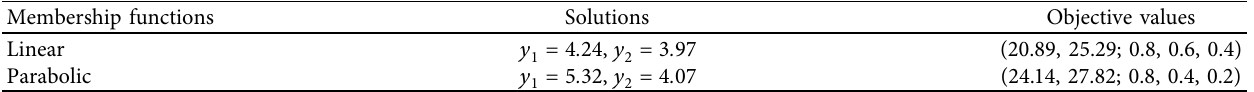
Table 1: Result discussion of Example